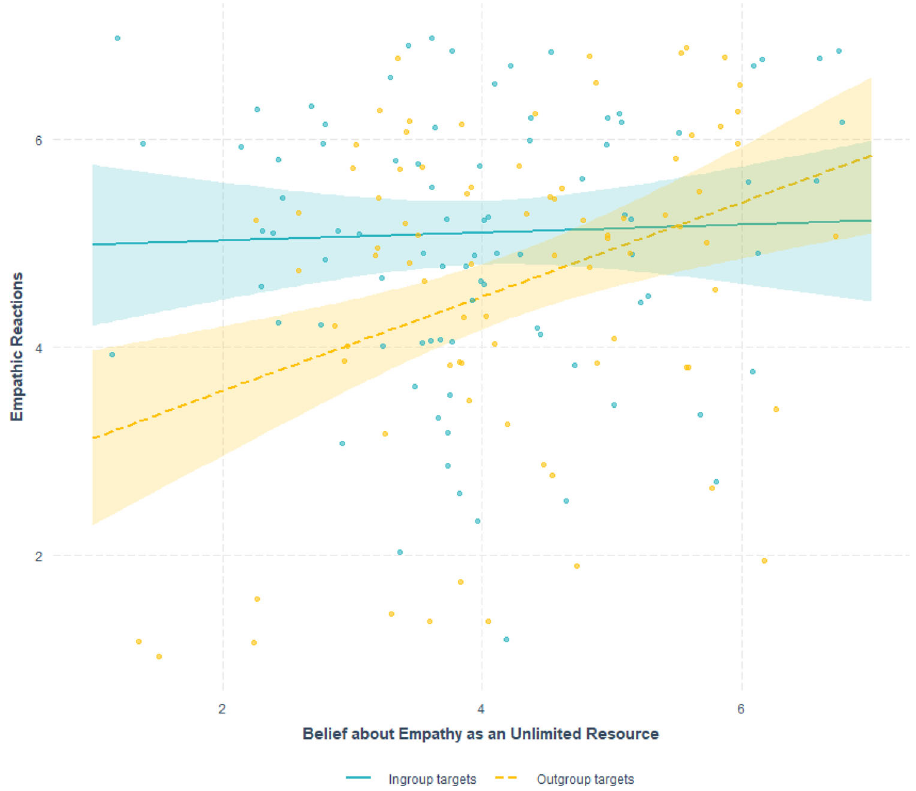
Fig.1|Theinteractiveeffectofcondition(ingrouptargets, n =92vs.outgroup targets, n =90) and belief about empathy as an unlimited resource on parti- cipants ’ empathic reactions toward ingroup and outgroup members. A sig- ni fi cant Condition×Belief interaction ( b =0.41, SE=0.17, t (178)=2.40, p =0.017; 95%CI=[0.074,0.76]).Asigni fi cantdifferencebetweenempathytowardsingroup andoutgroupmembersamongparticipantswhobelievedempathyismorelimited